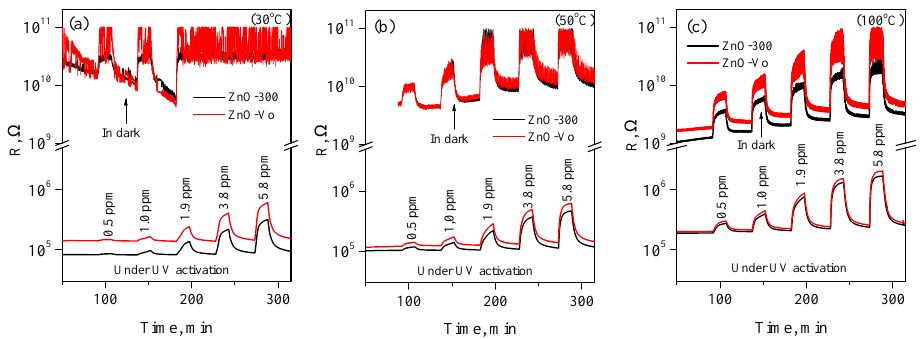
Figure 11. Gas-sensing measurements for ZnO-300 and ZnO-V O samples for NO 2 in dark and under UV activation at 30 ◦ C ( a ), 50 ◦ C ( b ), and 100 ◦ C ( c )